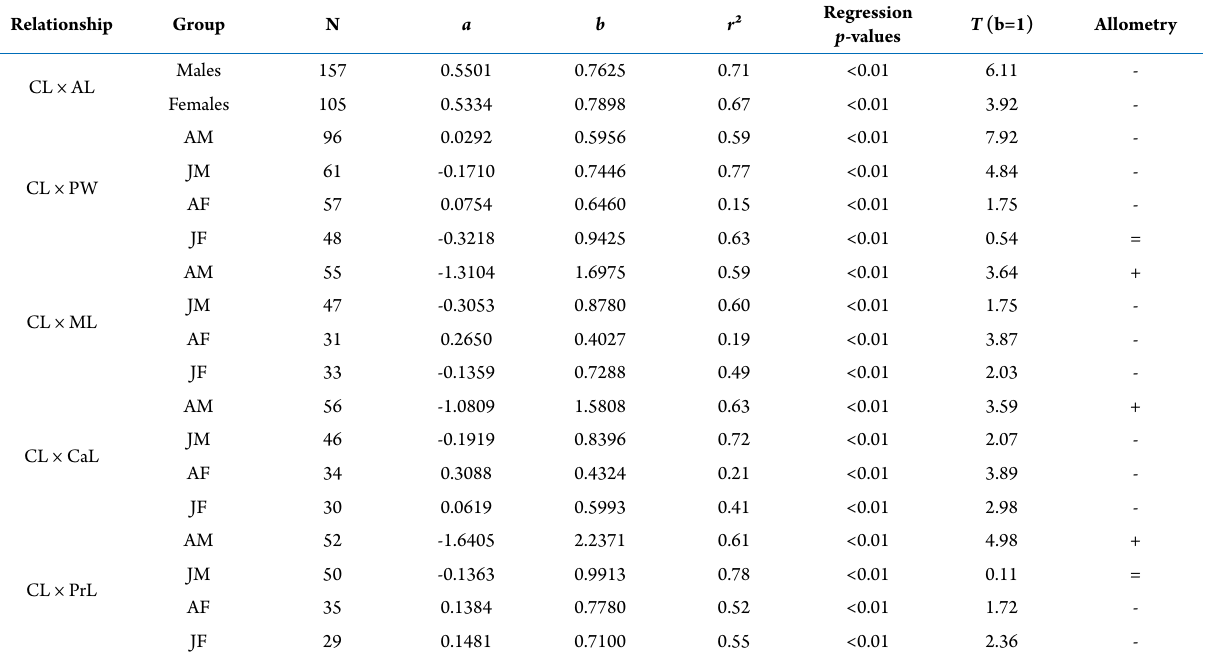
Table 2. Macrobrachium candango Mantelatto, Pileggi, Pantaleão, Magalhães, Villalobos and Álvarez, 2021. Regression analysis of morphometric data. The carapace length (CL) was used as an independent variable. CL: carapace length; AL: abdomen